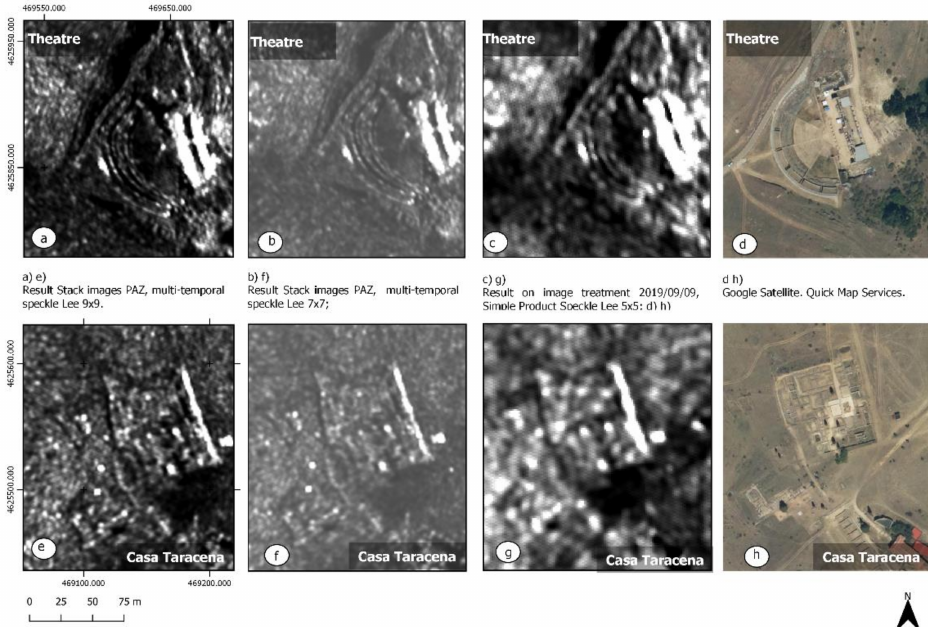
Figure 3. Comparison of a multi-temporal analysis of SAR-X radar images with individual treatment in the areas of the theatre ( a – d ), and Casa Taracena/ forum ( e – h